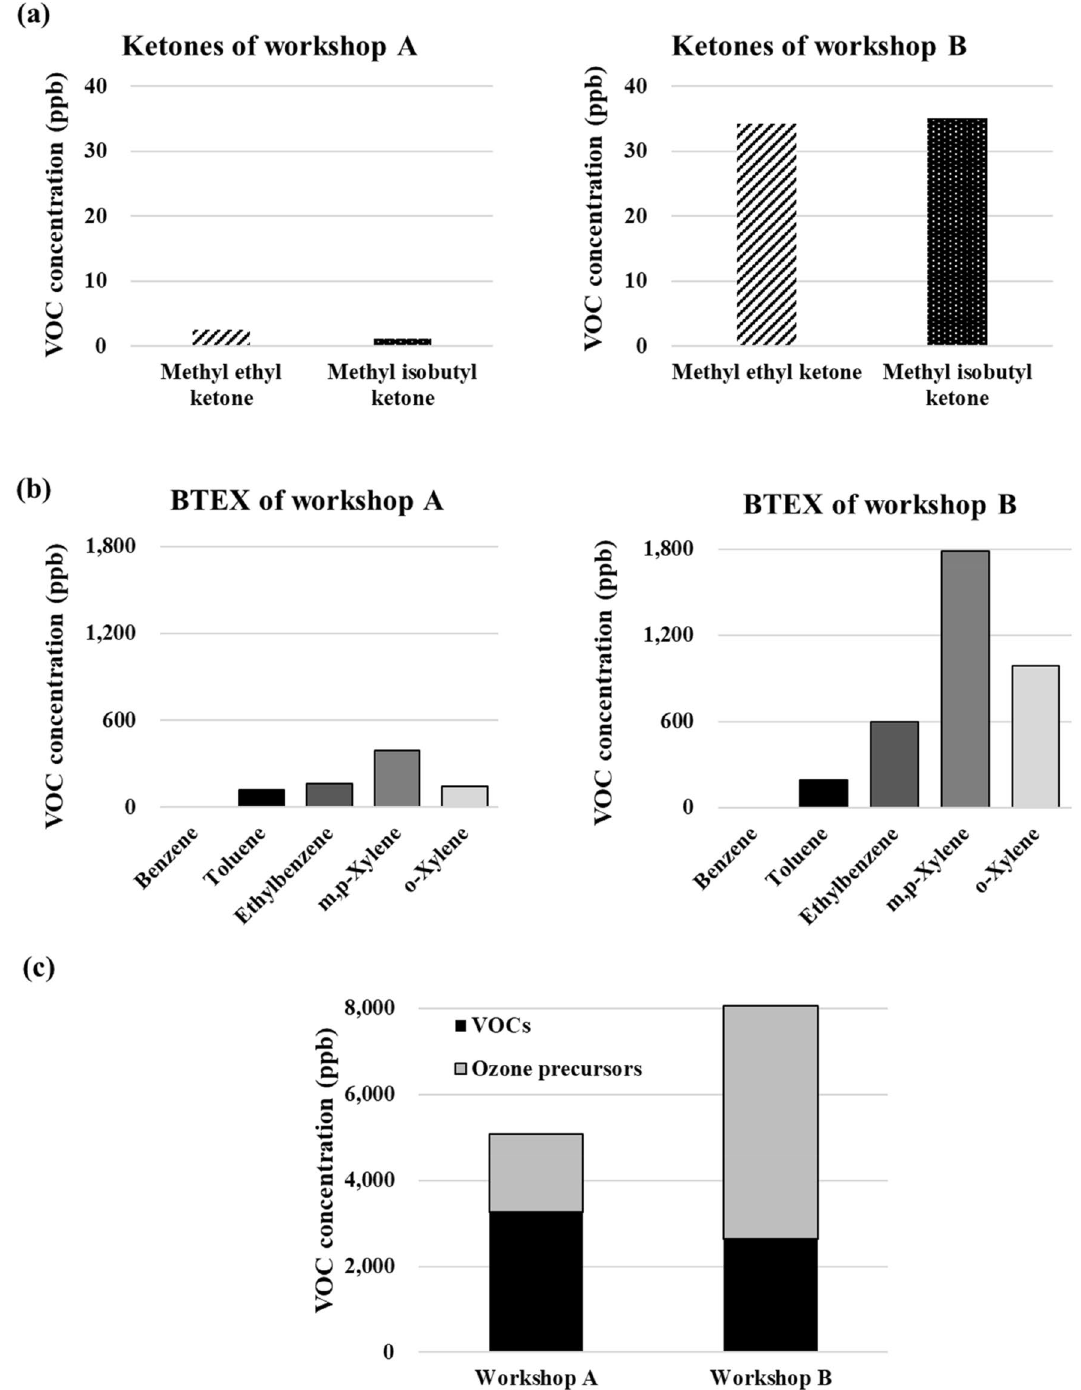
Figure 3. Categorization of volatile organic compounds (VOCs) emitted from workshops A and B into ketones, BTEX (benzene, toluene, ethylbenzene, and xylene), and O 3 precursors. ( a ) Ketones emitted from workshops A and B. ( b ) BTEX emitted from workshops A and B. ( c ) Emissions from workshops A and B based on VOC classification (O 3 precursors and VOC